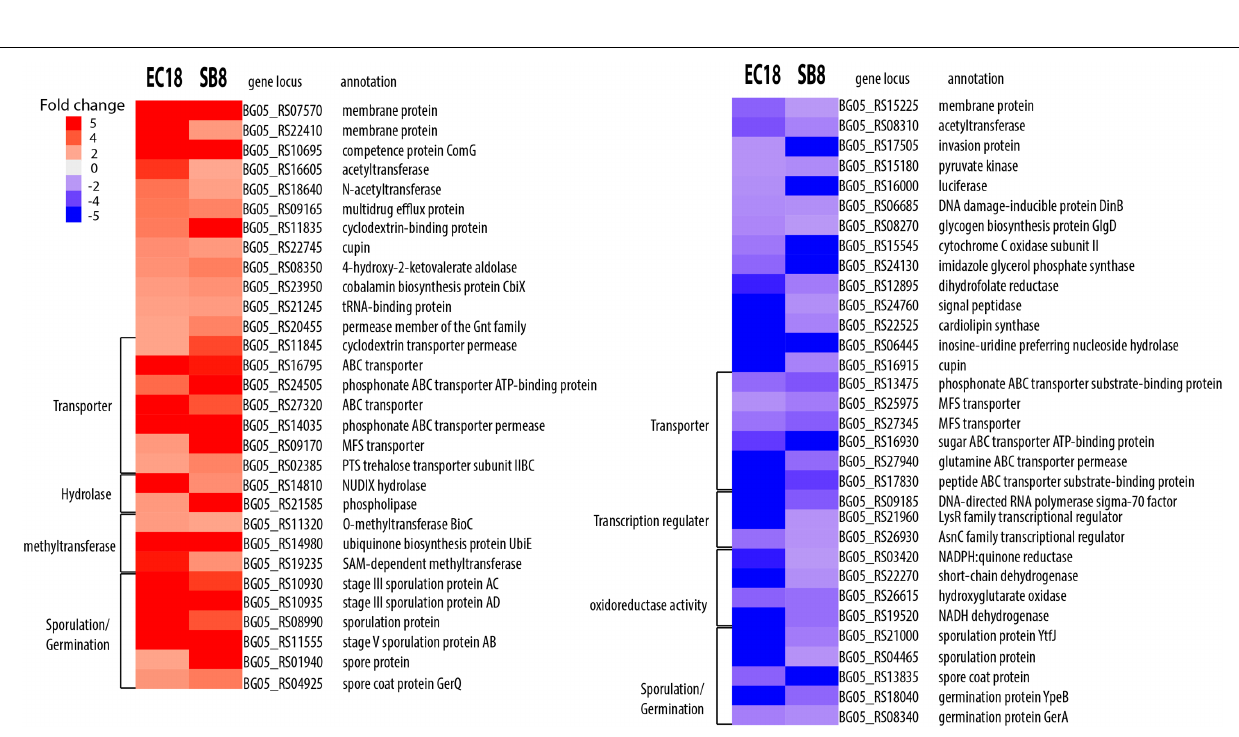
Frontiers in Microbiology |